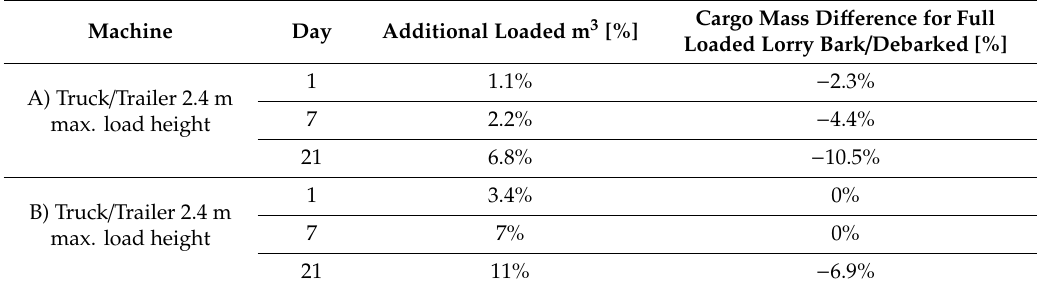
Table 4. Calculated di ff erences between debarked and bark assortments concerning additional load and total mass of the loaded truck and trailer combination, after di ff erent drying periods.